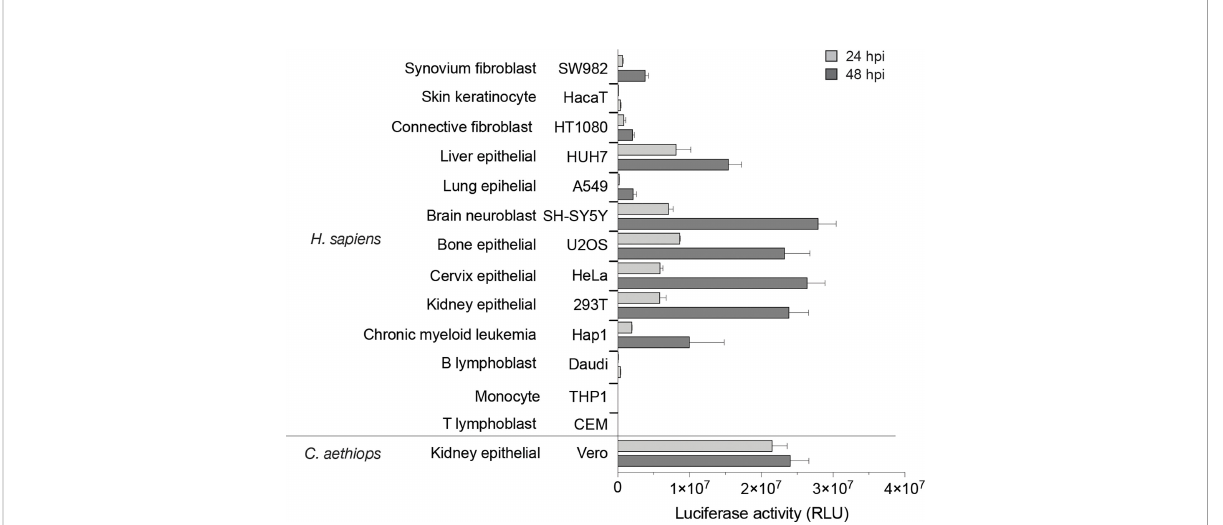
FIGURE 1 Susceptibility of vertebrate cell lines to MAYV infection. Cell lines were challenged with the MAYV-luc reporter virus used at an MOI of 0.1. Virus replication was monitored after 24 and 48 h by quanti fi cation of luciferase activity in cell lysates. Results are normalized according to protein concentration in the sample. Values are means of triplicates ± SD.